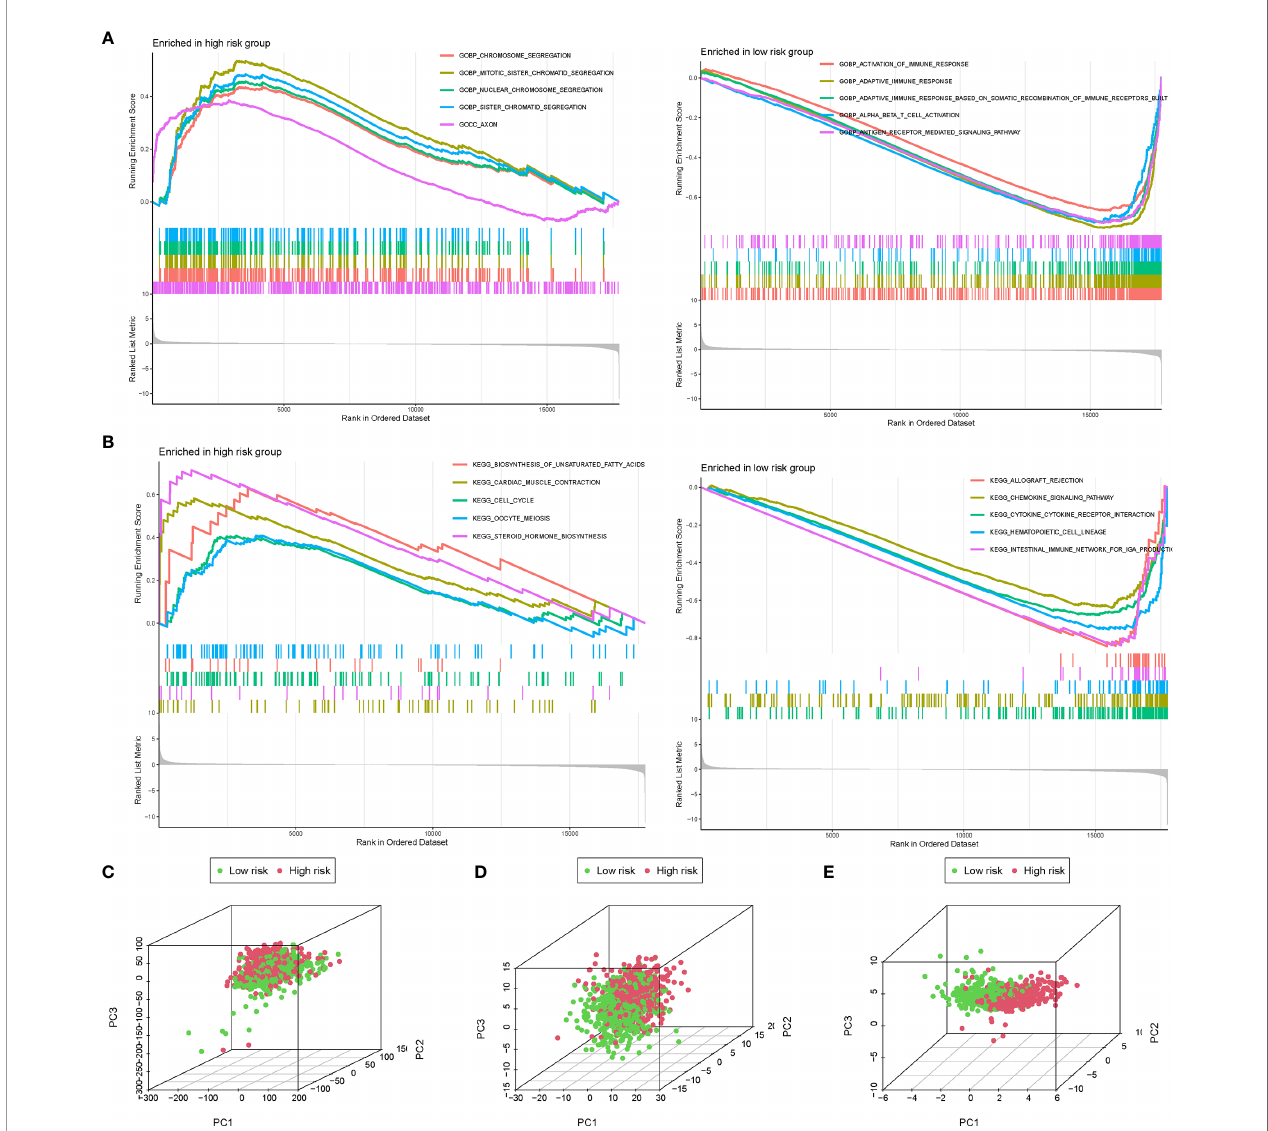
FIGURE 7 | The gene set enrichment analysis (GSEA) and principal component analysis (PCA) between the high- and low-risk groups. The GSEA was performed to identify and visualize the differential Gene Ontology (GO) (A) and Kyoto Encyclopedia of Genes and Genomes (KEGG) (B) enrichment analysis between the high- and low-risk subgroups. PCA for the visualization of all genes (C) , all aging-related genes (AGs) (D) , and risk signature genes (E) to distinguish high- and low-risk subgroups in The Cancer Genome Atlas (TCGA)